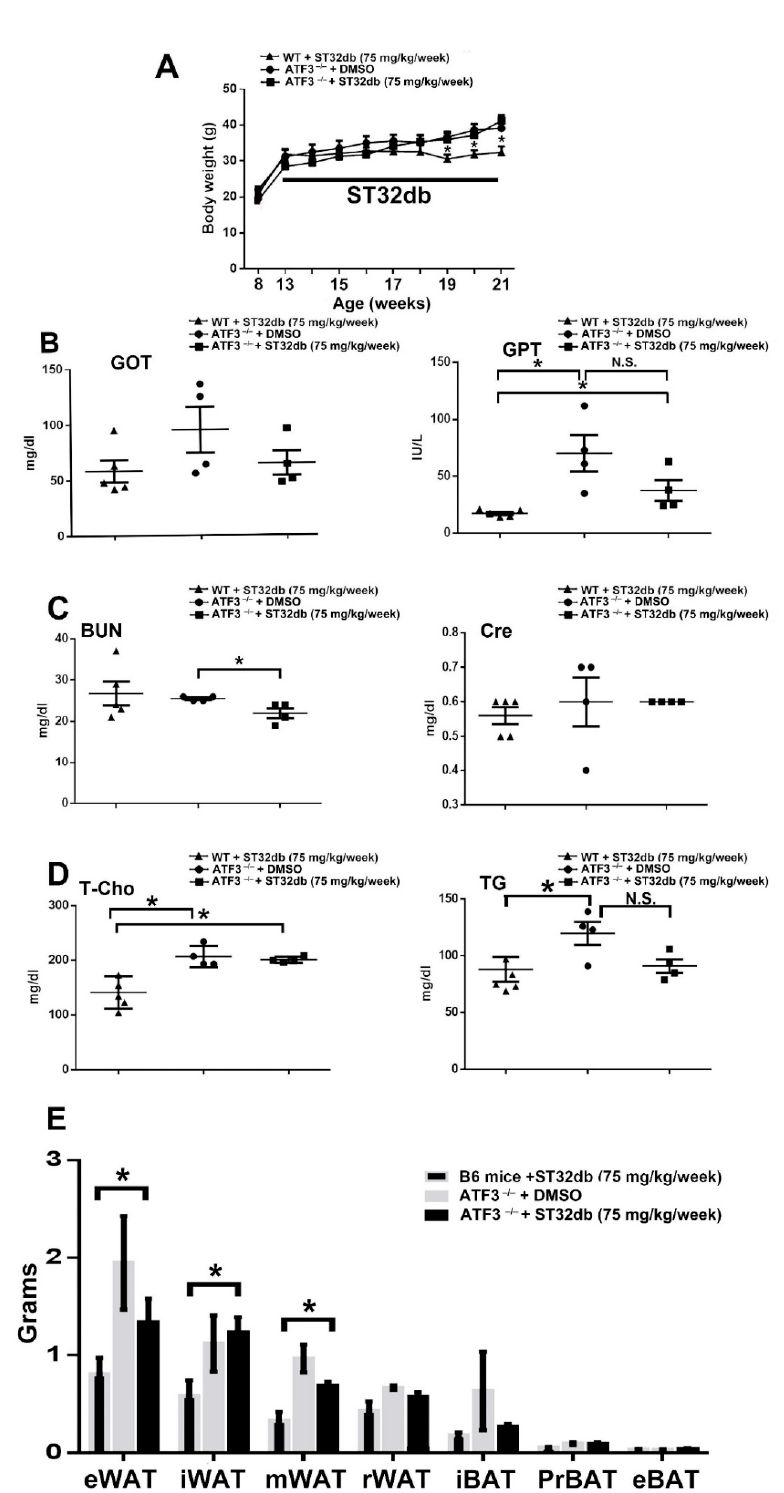
Figure 6. ST32db protects against HFD-induced obesity through an ATF3-specific pathway. ATF3 − / − mice fed an HFD for 12 weeks with or without i.p. injection of ST32db at 75 mg/kg/week were analyzed. ( A ) Body weight. ( B ) Serum levels of GOT and GPT. ( C ) Serum levels of BUN and creatinine. ( D ) Serum levels of total cholesterol (T-cho) and triglyceride (TG). ( E ) Weight of epididymal WAT (eWAT), inguinal WAT (iWAT), mesenteric WAT (mWAT), retroperitoneal WAT (rWAT), inter- scapular BAT (iBAT), peri-renal BAT (prBAT), and epididymal BAT (eBAT). Data are the mean ± SEM; * p < 0.05. For ( A – E ), n = 4 per group, except for WT+ST32db ( n =